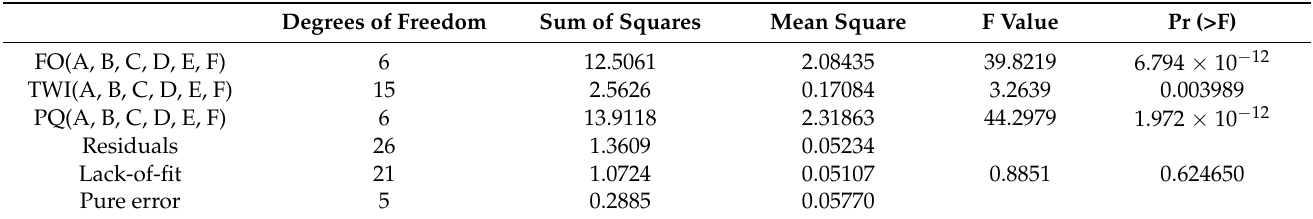
Table 2. Analysis of variance (ANOVA) for the fitted quadratic polynomial model. Degrees of Freedom